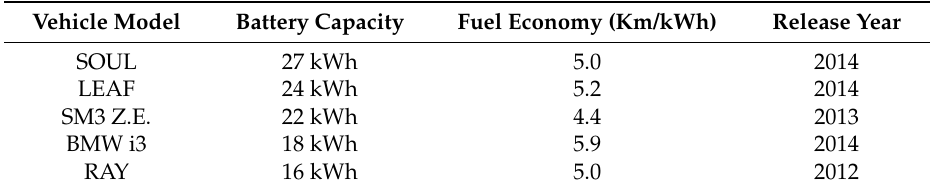
Table 3. Electric vehicle charging tariff [16].